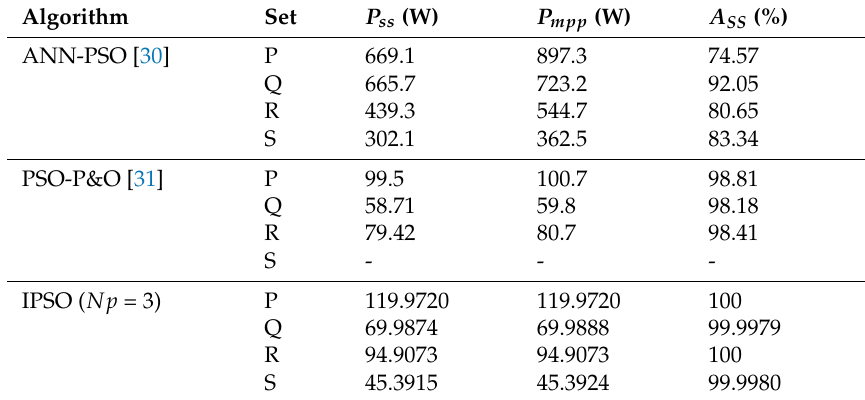
Table 8. Comparison accuracy between the Improved Particle Swarm Optimisation (IPSO),